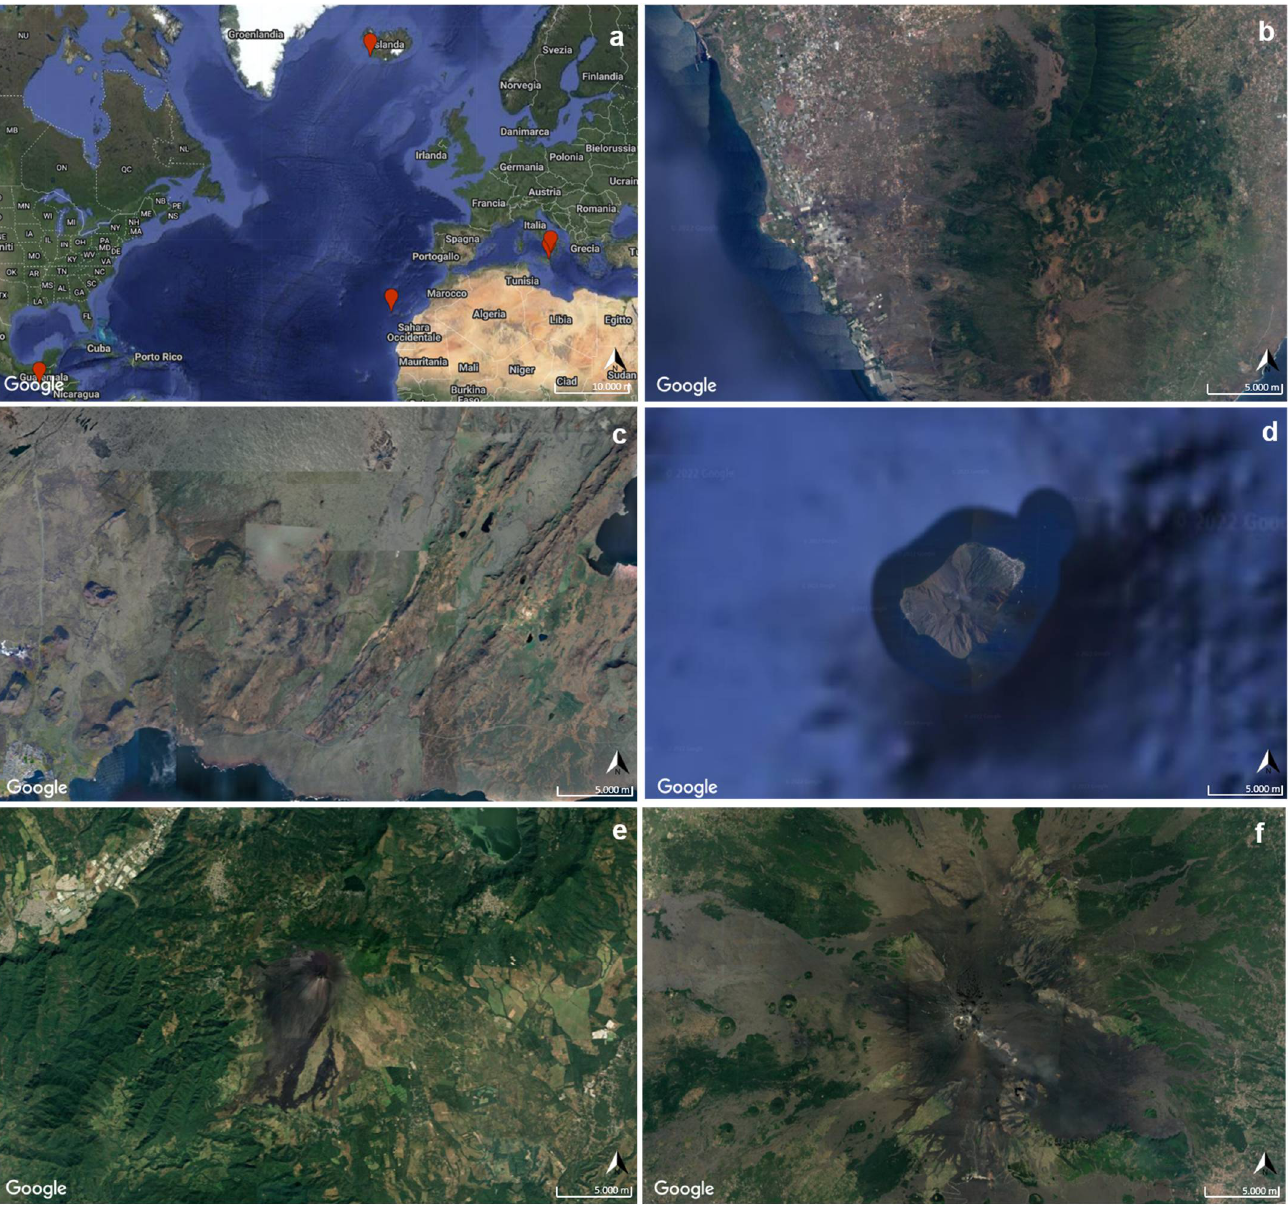
Figure 1. Volcanoes used in the train and test phase for the two models, ( a ) targeted volcanoes localization, ( b ) Mt. Etna, ( c ) Cumbre Vieja, ( d ) Geldingadalir, ( e ) Stromboli, and ( f ) Pacaya. All the images were captured via Google Earth Engine.